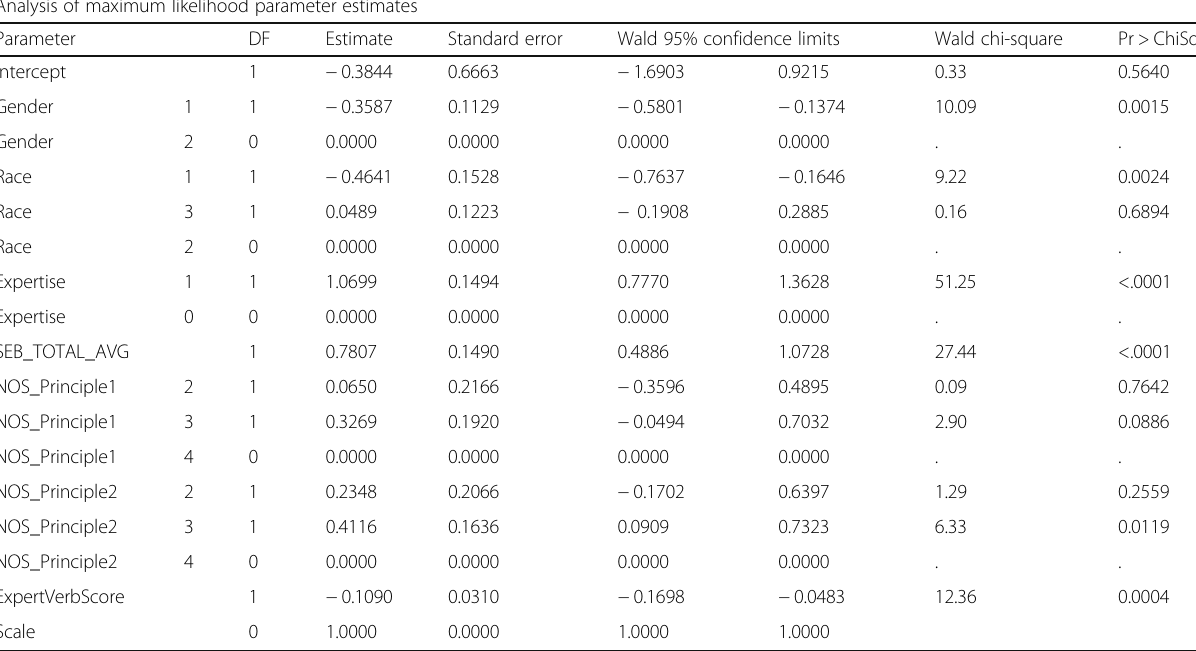
Table 4 Parameter estimates of Poisson count regression for number of actions Analysis of maximum likelihood parameter